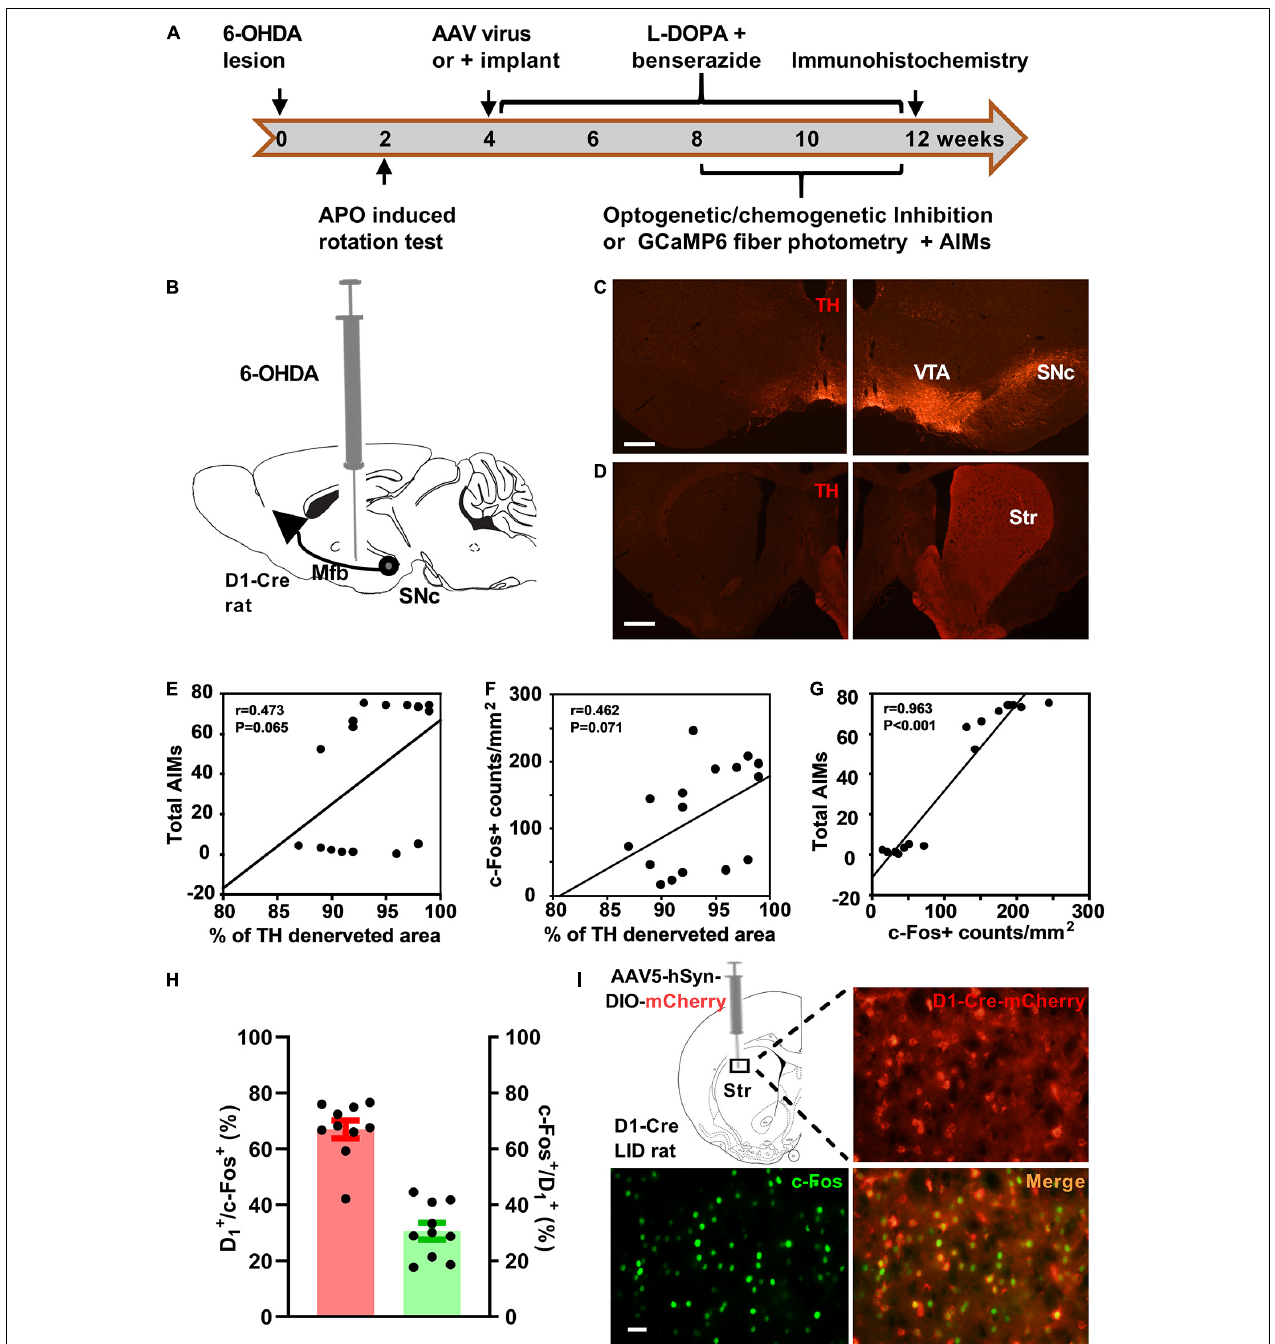
FIGURE 1 | Striatal D 1 receptor-positive neurons were activated in the rat model of levodopa-induced dyskinesia (LID). (A) Experimental design of the study. (B) Dopaminergic lesion was induced by stereotaxic injection of 6-hydroxydopamine (6-OHDA) in the left medial forebrain bundle (Mfb). Photomicrographs of tyrosine hydroxylase (TH) staining of substantia nigra pars compacta (SNc, C ) and striatum (Str, D ) on the injected side (left; scale bar = 500 µ m) and contralateral intact side (right). Simple linear regression analysis illustrating the correlation between the percentage of total striatum dopaminergic denervation and the total Abnormal Involuntary Movement scale (AIMs) scores ( E ; n = 16) or striatal c-Fos + neuron counts/mm 2 ( F ; n = 16). Linear regression analysis illustrating the correlation between striatal c-Fos + neuron counts/mm 2 and the AIMs scores ( G ; n = 16). Quantification ( H ; red: percentage of c-Fos + neurons positive for D 1 -Cre-mCherry, green: percentage of D 1 -Cre-mCherry + neurons positive for c-Fos) and representative histology ( I , scale bar = 50 µ m) of c-Fos immunoreactivity in the striatal brain section of D 1 -Cre-mCherry LID rats after levodopa administration. APO, apomorphine; Cre, cyclization recombinase; AAV, adeno-associated virus; AIMs, Abnormal involuntary movement scale; VTA, ventral tegmental area.